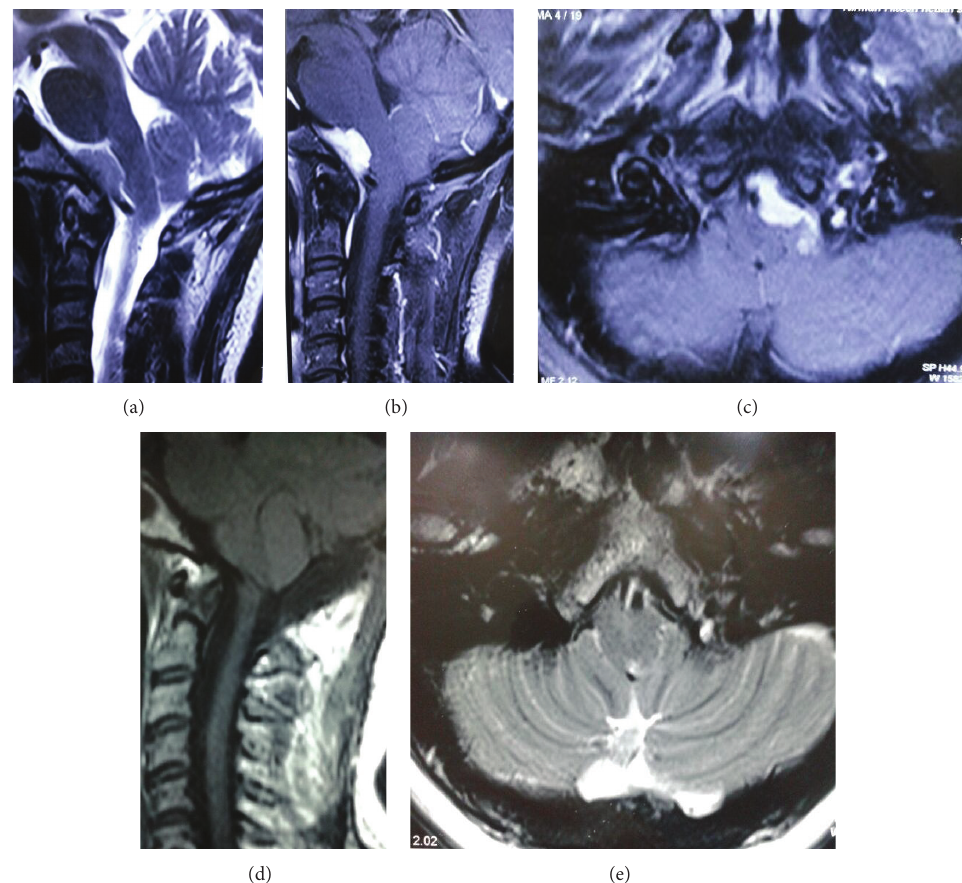
Figure 1: (a) T2 weighted sagittal image; (b) postcontrast T1 weighted sagittal image; (c) postcontrast T1 weighted axial image: magnetic resonance imaging (MRI) showing anterolaterally placed, homogenously enhancing dural based lesion in the foramen magnum encasing the left vertebral artery suggestive of meningioma. (d) T1 weighted sagittal image and (e) T1 weighted axial image: postoperative MRI showing complete excision of tumor.